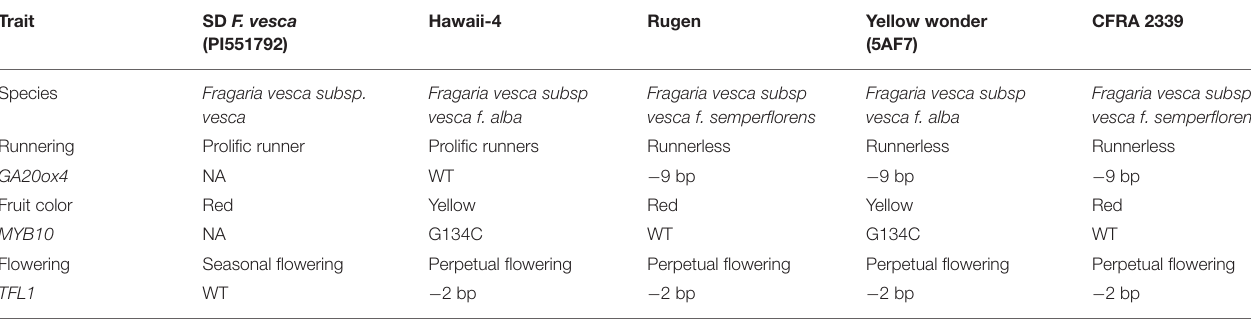
TABLE 1 | Genotype and phenotype comparisons among several F. vesca accessions with different fruit, runner, and flowering traits.